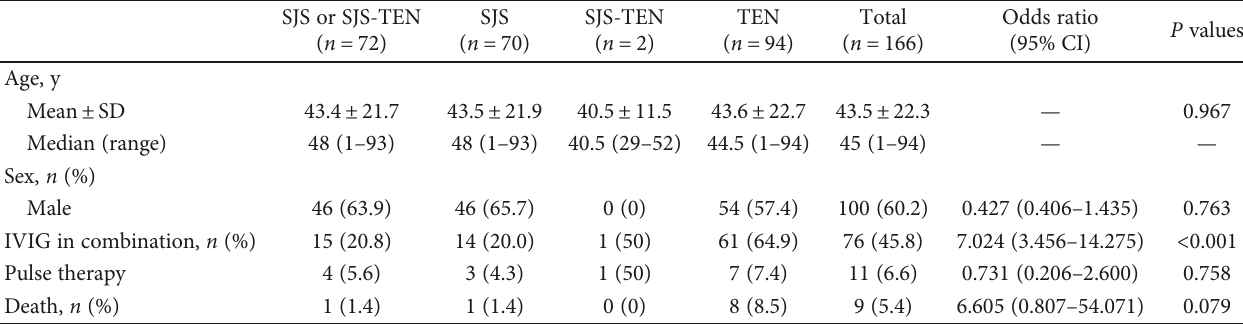
Table 1: Demographic data, treatment, and prognosis patients with